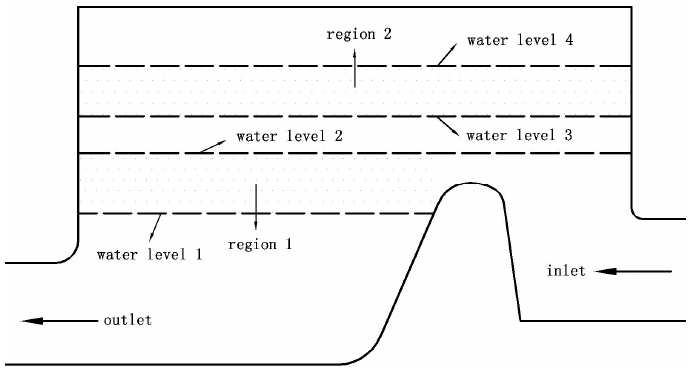
Figure 5. Free surface sloshing regions for self-induced sloshing.